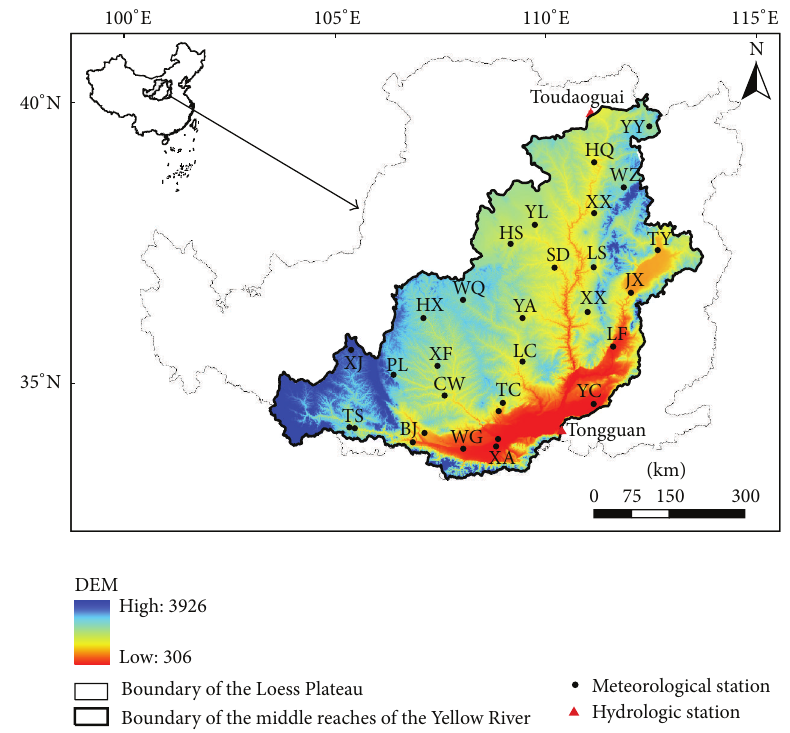
Figure 1: Location of the selected 26 meteorological stations on a DEM of middle reaches of the Yellow River,